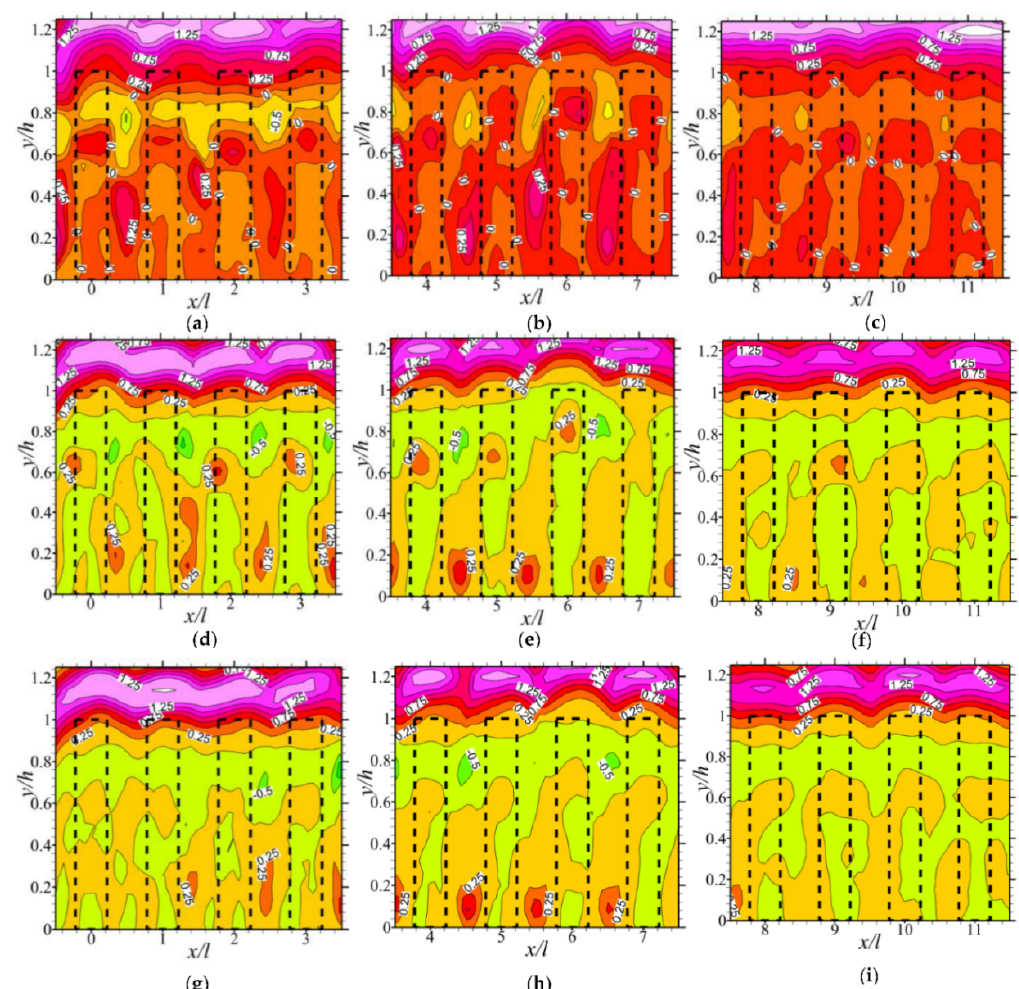
Figure 6. Iso-contours of mean spanwise vorticity Ω z = ∂ V /∂ x − ∂ U /∂ y normalized by the maximum entry flow velocity and the rod diameter. Plots ( a – c ) are results of measurements taken at z = l /2 in Test A . Plots ( d – f ) were extracted from measurements taken at z = l /2 in Test B . Plots ( g – i ) were extracted from measurements taken at z = − l /2 in Test B . Note that for each plot, dashed lines indicate locations of porous medium rods.